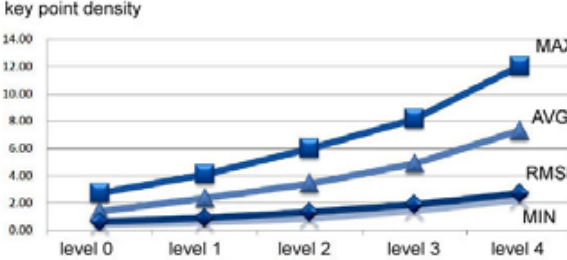
Figure 8. Key point density on each pyramid level (unit: points /1000 pixels)